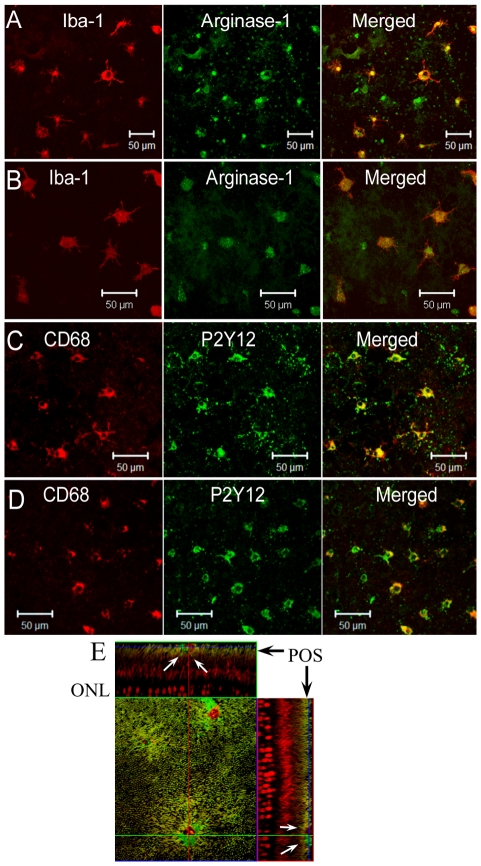
Phenotype of subretinal macrophage/microglia.RPE/choroidal flatmounts from aged (20–24 months) WT (A, C) and CCL2 KO (B, D) mice were dual stained for Iba-1/arginase-1 (A, B), or CD68/P2Y12 (C, D) and observed by confocal microscopy. Images presented are representatives from 6 mice in each group. E, Z-stack images of a retinal flatmount stained for Iba-1 (green) and Propidium iodide (PI) showing three Iba-1+ cells in the photoreceptor outer segment layer. Arrows: cell dendrites pointing toward the inner retina in z-sections.